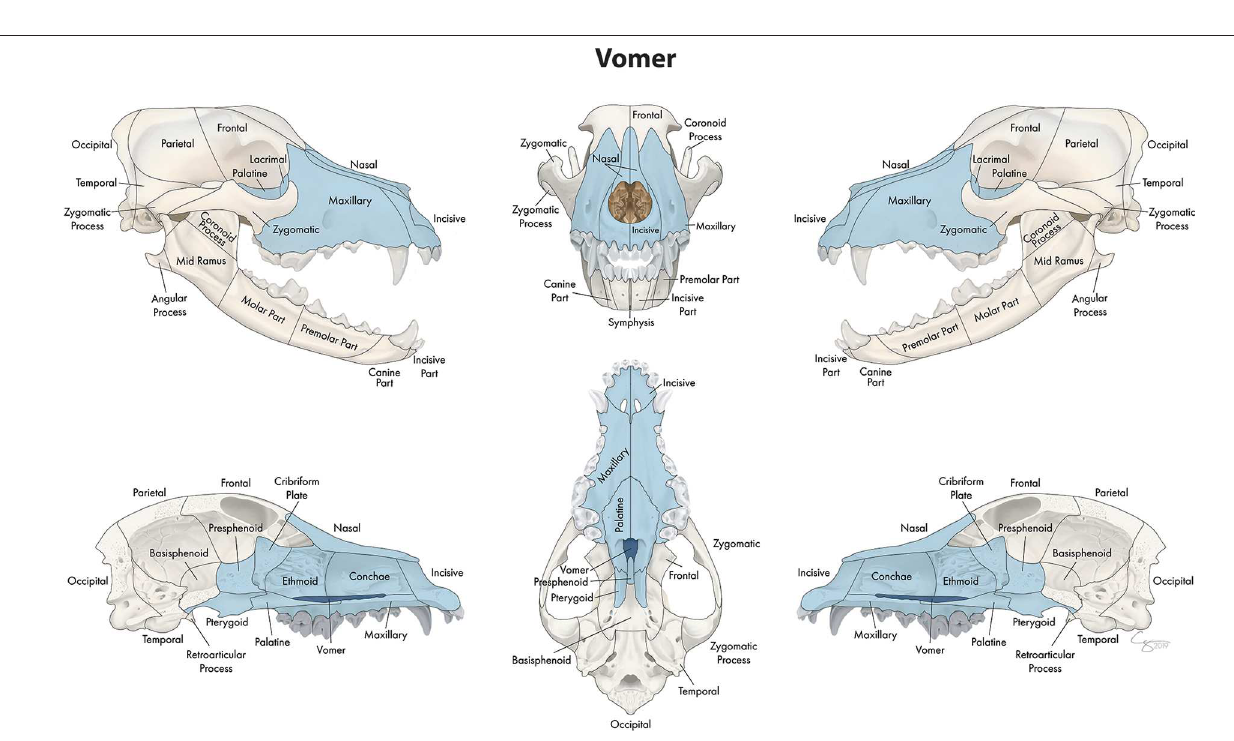
Frontiers in Veterinary Science | www.frontiersin.org